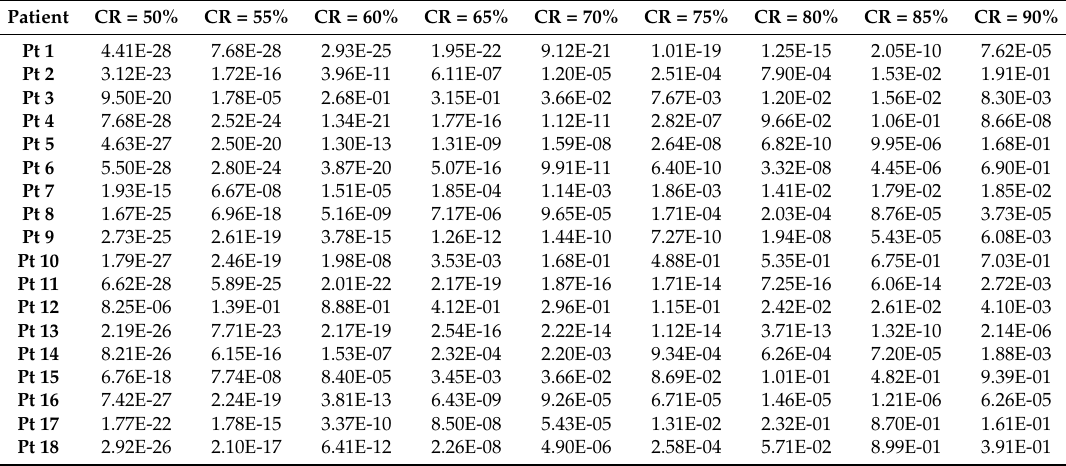
Statistical comparison ( p values) of the SSIM of the two hemispheres (analysis of High-Density EEGs).